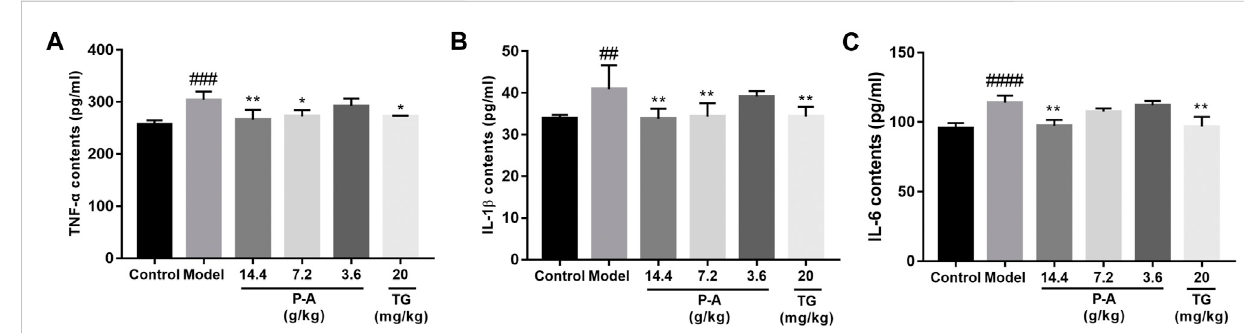
FIGURE 7 EffectsoftheP-AdrugpaironTNF- α ,IL-1 β ,andIL-6levelsintheserumofRArats. (A) EffectoftheP-AdrugpaironTNF- α contents. (B) Effectofthe P-A drug pair on IL-1 β contents. (C) Effect of theP-A drug pair on IL-6 contents. The data represent the mean ± SD. # p < 0.5, ## p < 0.01, ### p < 0.001, #### p < 0.0001 vs. control group; * p < 0.5, ** p < 0.01, *** p < 0.001, **** p < 0.0001 vs. model